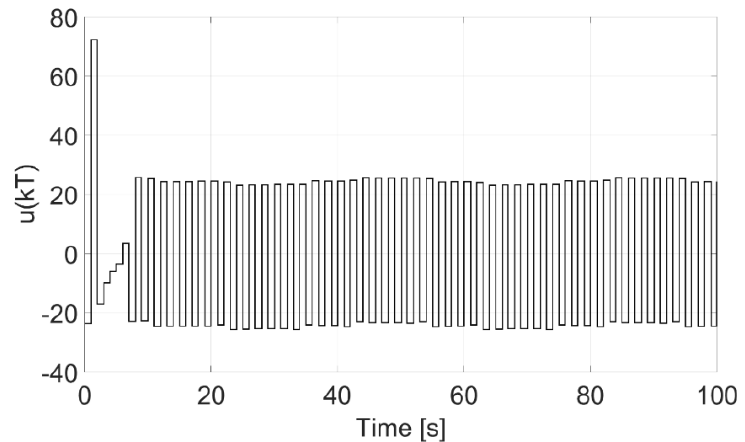
Figure 8. Control signal of Gao’s reaching law controller.